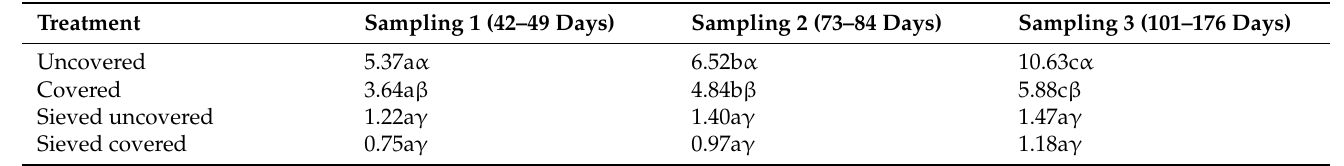
Table 4. Average cumulative dry matter loss, as %, during storage. Different letters within rows indicate significant differences between storage duration, and different Greek letters in columns indicate significant differences between